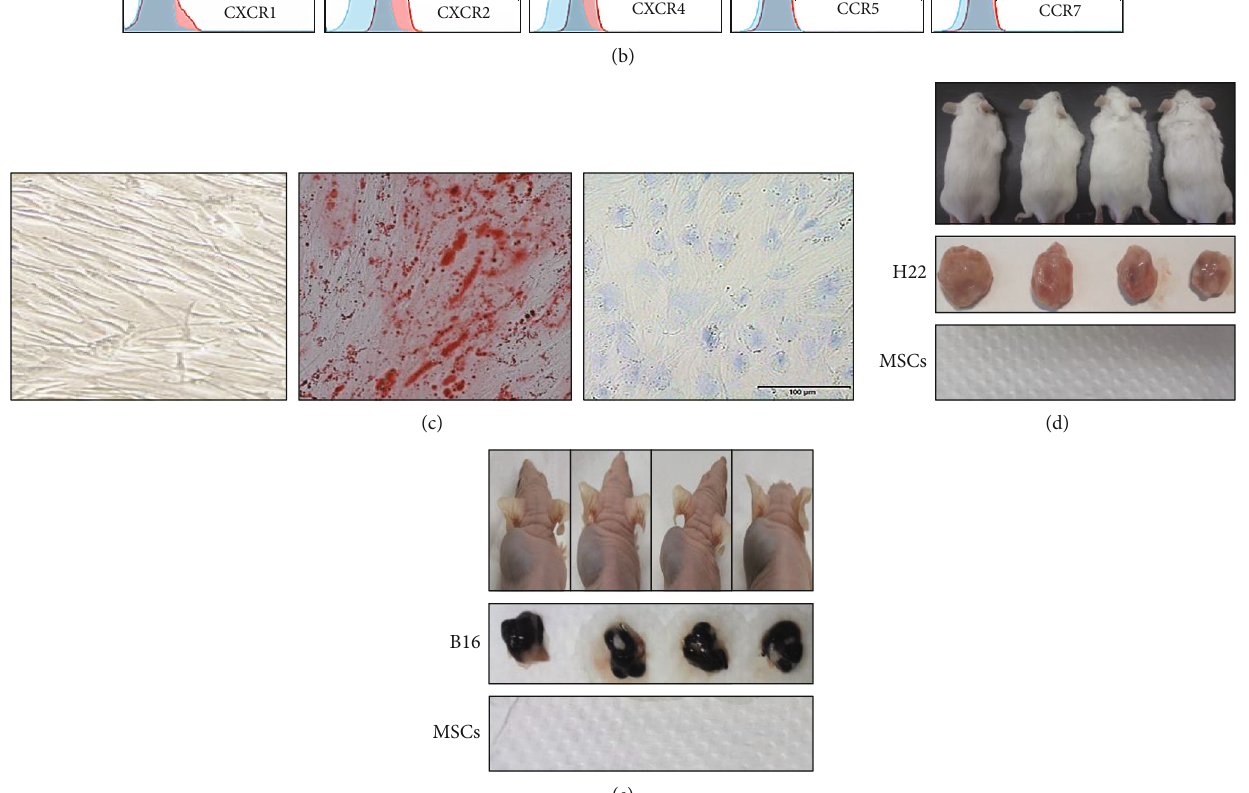
Figure 1: Characterization and the safety evaluation of HUC-MSCs isolated from Wharton jelly of the umbilical cord. (a) Identi fi cation of the expression of MSC markers by fl ow cytometry. CD29, CD44, CD90, and CD105 were highly expressed in HUC-MSCs, while CD31, CD34, CD45, and HLA-DR were lowly expressed. (b) HUC-MSCs express detectable chemokine receptors. (c) Multilineage di ff erentiation potential of HUC-MSCs. HUC-MSC control (left); Oil Red O staining for adipogenic di ff erentiation (middle); Alcian Blue staining for osteogenic di ff erentiation. To make sure of the safety of HUC-MSC injection, tumor-bearing experiment was used in immunode fi ciency and normal immunity mice. Error bars: mean ± SD . ∗ p < 0 : 05 ; ∗∗ p < 0 : 01 ; ∗∗∗ p < 0 : 005 . (d) The same amount of HUC-MSCs and H22 cells ( 5 × 10 6 cells) was, respectively, injected into the left and right side of ICR mice to compare tumor formation ability of HUC-MSCs and H22 cells ( n = 6 ). (e) The same amount of HUC-MSCs and B16 cells ( 1 × 10 6 cells) was, respectively, injected into the right and left side of nude mice to compare tumorigenesis ability in vivo ( n = 7